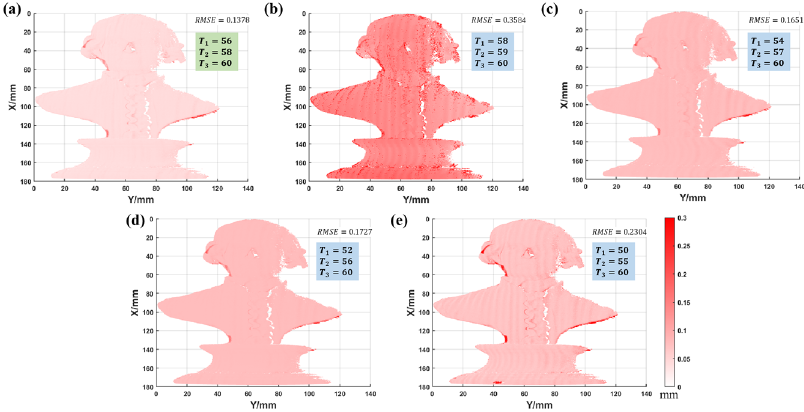
Figure 17. Measurement results under different period combinations. ( a , e ) The statue and deformed fringe pattern. ( b ) Ground truth. ( c ) Combination 1: 56, 58, 60 (combination 1 is optimal combina- tion). ( d ) Combination 2: 58, 59, 60. ( f ) Combination 3: 54, 57, 60. ( g ) Combination 4: 52, 56, 60. ( h ) Combination 5: 50, 55, 60 (the small images in the upper right are enlarged images of the selected region).